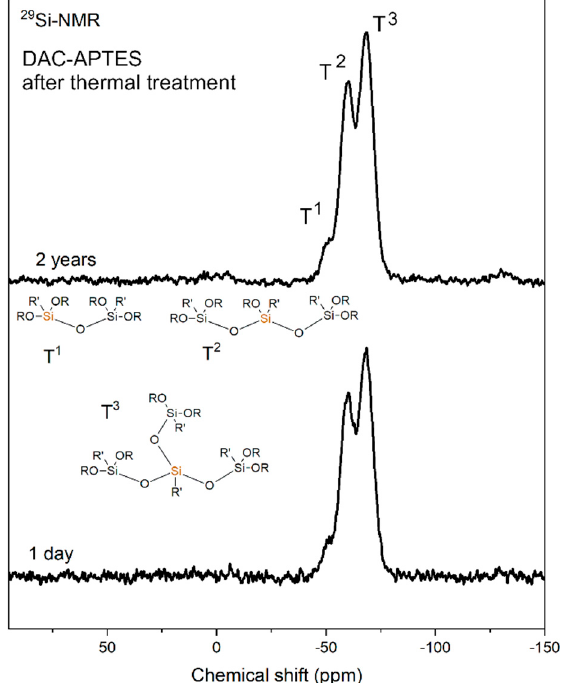
Figure 2. 29 Si cross-polarization/magic angle spinning (CP/MAS) nuclear magnetic resonance (NMR) spectra of DAC-APTES reaction product after thermal treatment: the spectrum after 1 day (bottom), and spectrum of the same sample after 2 years (top), with the schematic representations of the structures T 1 , T 2 , and T 3 . R=H, C (from DAC); R ′ =C (from (CH 2 ) 3 -NH 2 side chain in APTES).